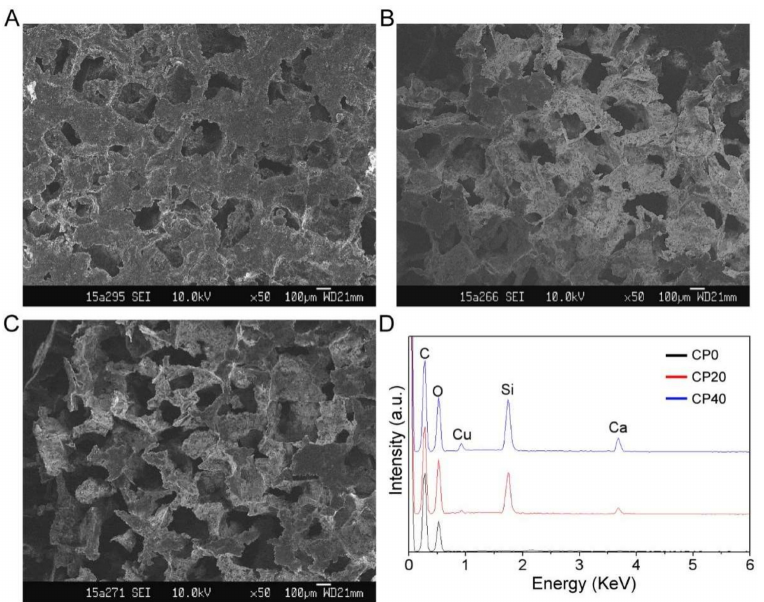
Figure 2. FESEM images of CP0 ( A ), CP20 ( B ), and CP40 ( C ), and EDS analysis ( D ) of the elemental composition of the